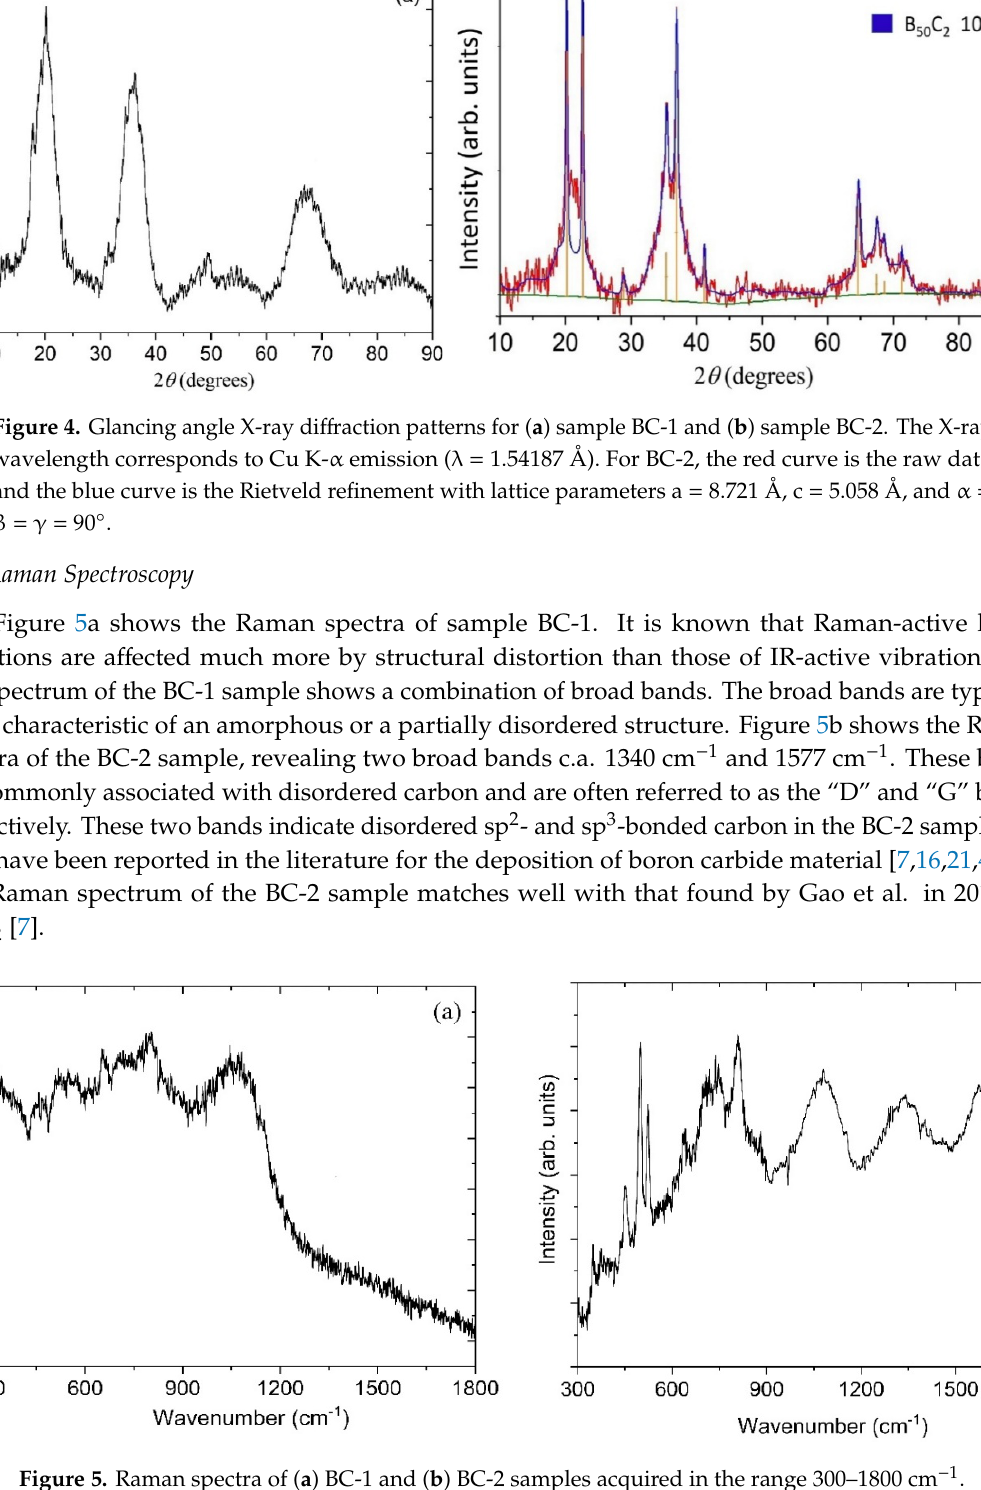
Figure 5. Raman spectra of ( a ) BC-1 and ( b ) BC-2 samples acquired in the range 300–1800 cm −1 .